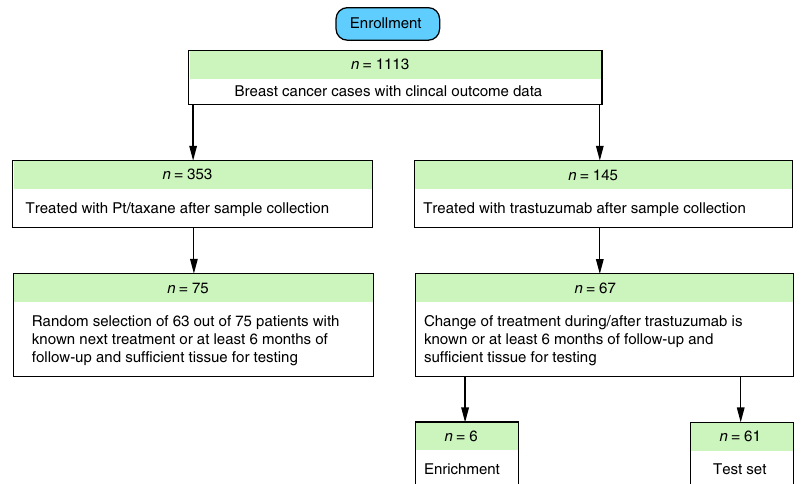
Fig. 1 Enrollment of patients for poly-ligand pro fi ling. The fl ow chart illustrates the rationale and the numbers of patients for inclusion in the test set and those used for the ssDNA library enrichment. A comparative analysis of the demographic and clinical details for the excluded 78 patients and the enrolled 67 patients (Supplementary Data 2) shows no bias among tested clinical and demographic factors, thus the 67 enrolled cases are